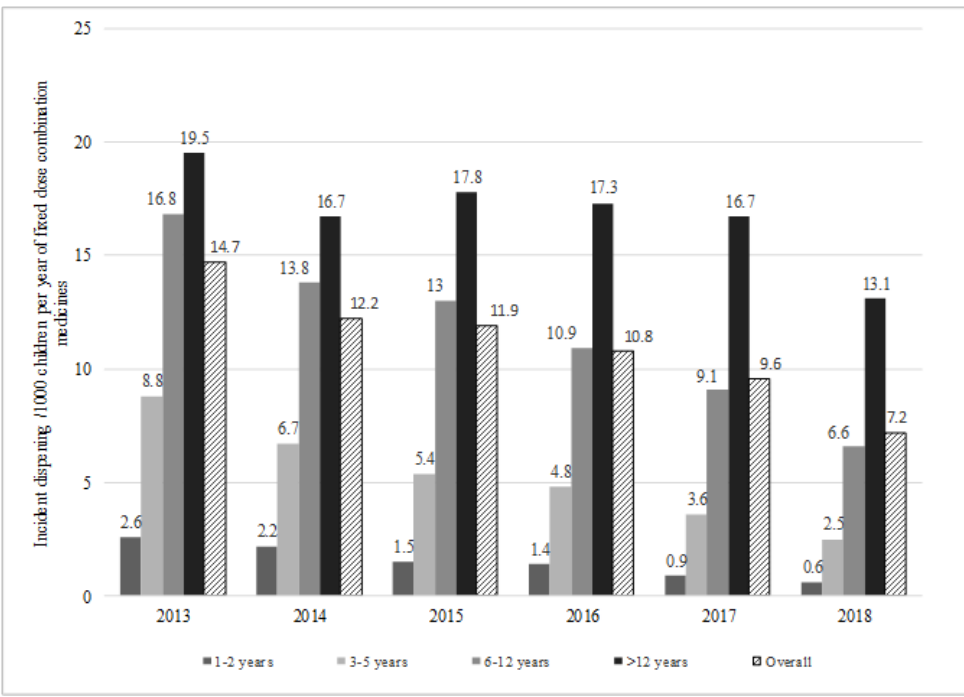
Figure 1. Year and age specific incident dispensing of any fixed dose combination medicines in 10% PBS sample of Australian children aged 1–18 years, 2013–2018.